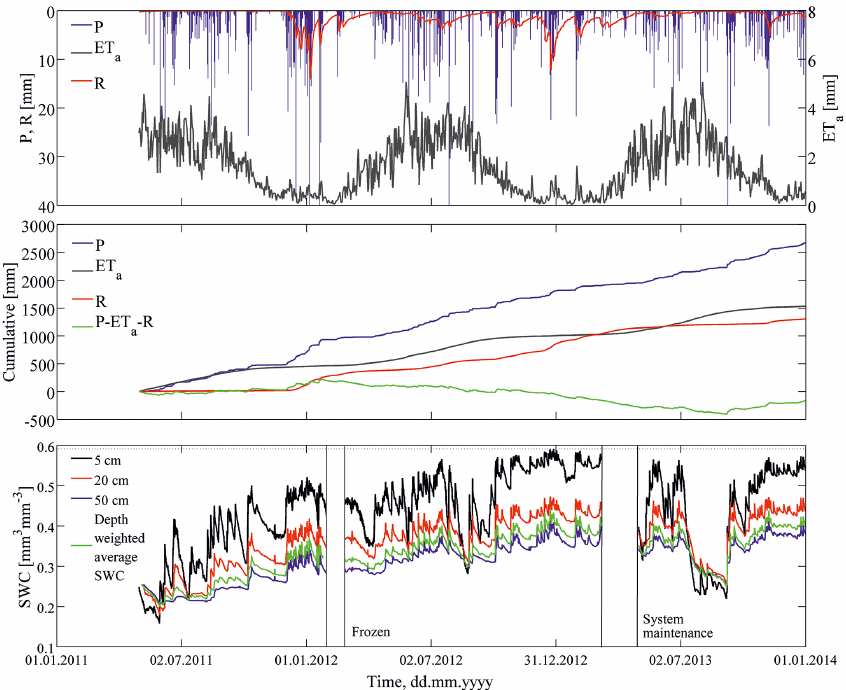
Figure 8. Daily and cumulative time series (1 May 2011 to 31 December 2013) of precipitation ( P ), runoff ( R ), actual evapotranspiration (ET a ), and spatial mean soil water content (SWC) at three depths. The SWC data contains two major gaps due to frozen soil conditions and maintenance of the SoilNet system. The dashed line indicates the soil porosity determined from the soil samples (0.59cm 3 cm − 3 ).